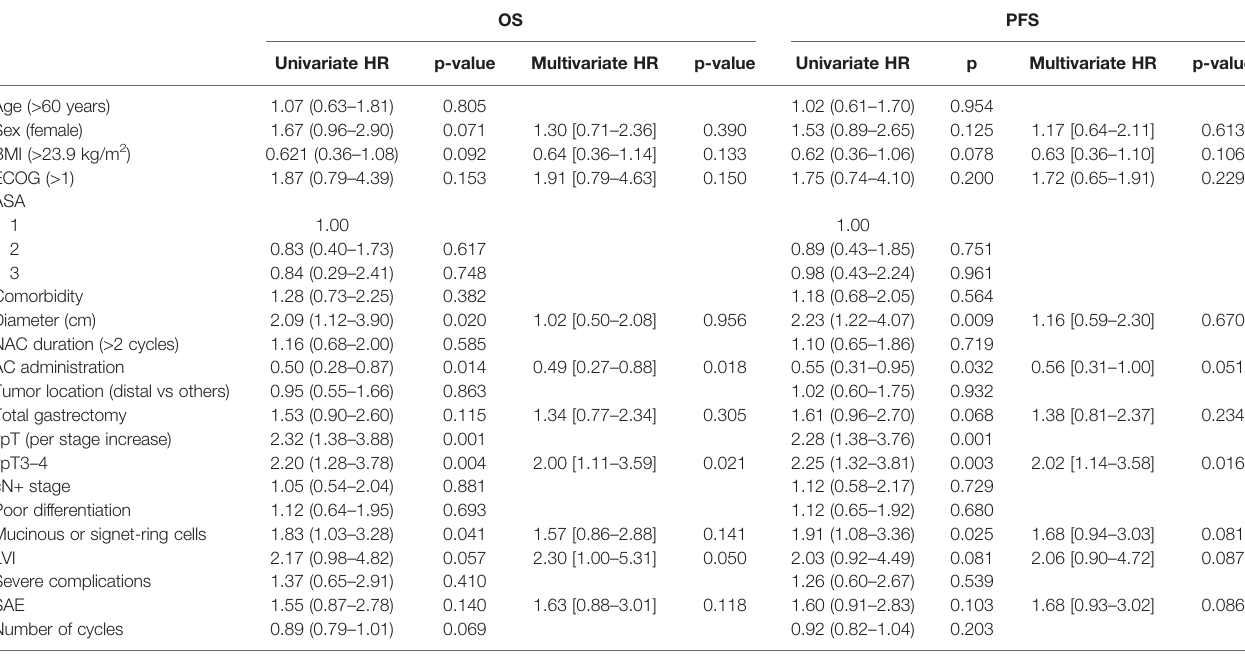
TABLE 3 | Univariate and multivariate analyses of prognostic